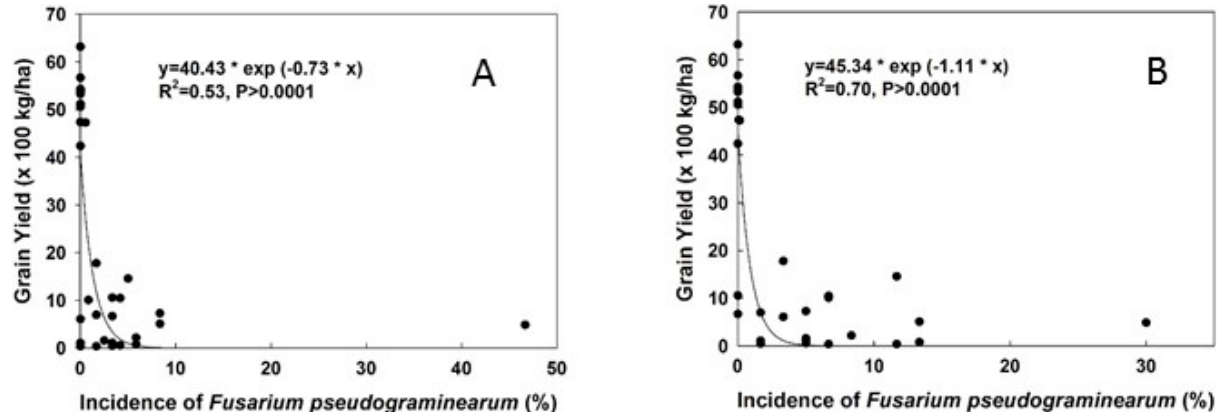
Figure 5. Mean of Fusarium pseudograminearum ( Fpg ) incidence of infection on roots and stem bases as a function of grain yield reduction for durum wheat cultivated in INRAT station at Kef over three experimental cropping seasons (2007/08, 2008/09 and 2009/10). Models were fitted with an exponential decay model with two